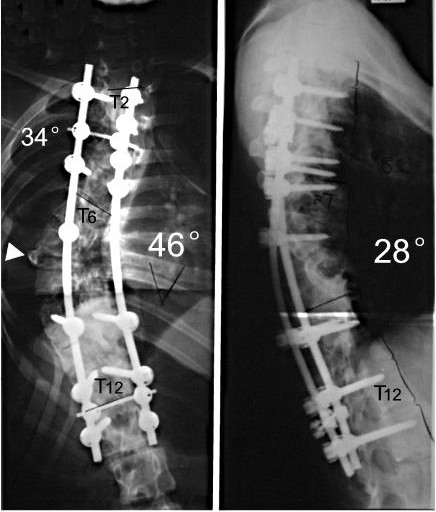
The correction rates are 65.2% and 74.1% after second stage osteotomy and instrumentation.